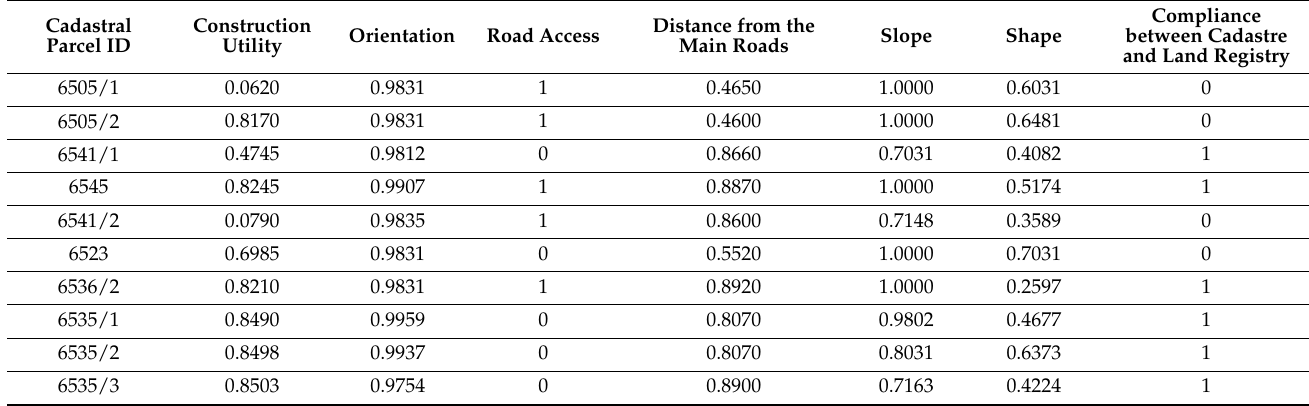
Table 3. Standardized results of cadastral